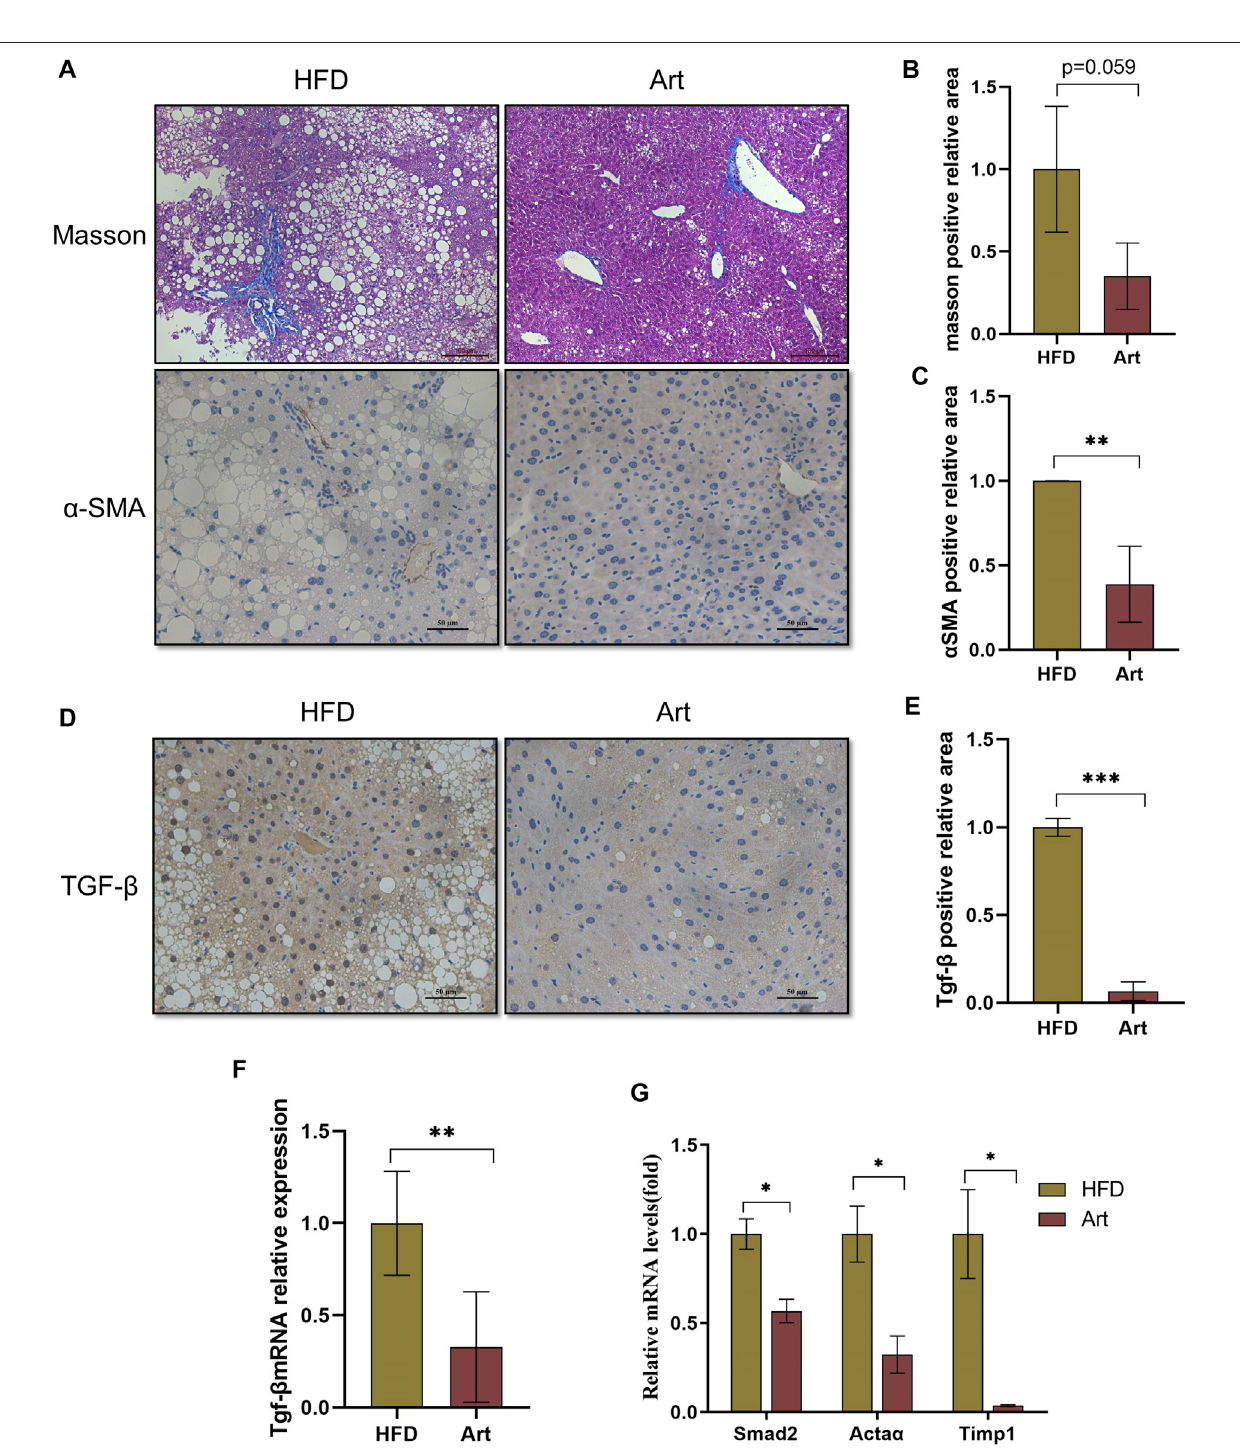
FIGURE 7 | Artemether prevented NASH-induced liver fi brosis. (A) From top to bottom: Masson ’ s staining (scale bar: 50 μ M) and α -SMA immunohistochemistry (scalebar:50 μ M). (B) Quanti fi cationofMasson ’ sstainingarea. (C) Quanti fi cationofimmunohistochemicalstainingfor α -SMA. (D) TGF- β immunohistochemicalstaining (scale bar: 50 μ M). (E) Quanti fi cation of TGF- β immunohistochemical staining. (F,G) Real-time PCR analysis of hepatic TGF- β expression (F) Acta 2 , Timp1 , and Smad2 (G) in the liver. * p < 0.05, ** p < 0.01, and *** p < 0.001.